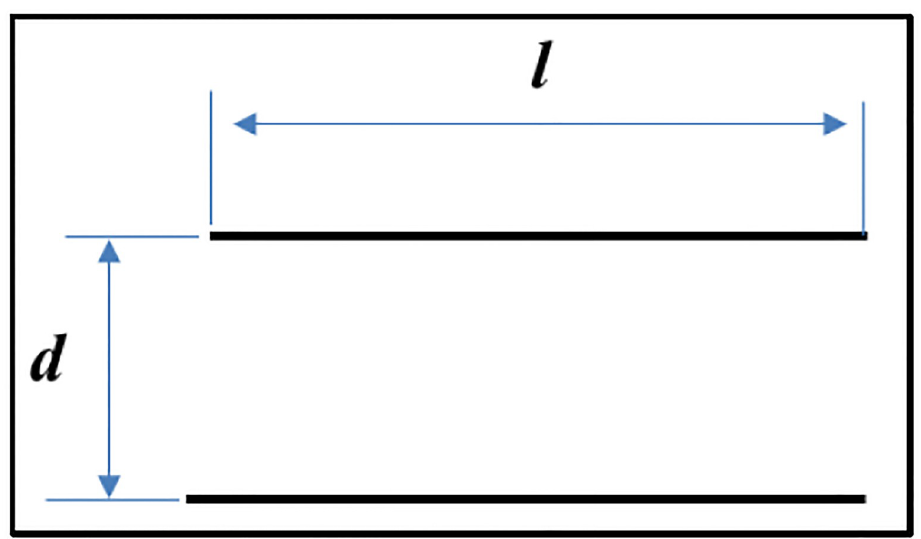
Fig 6. Two ideal parallel